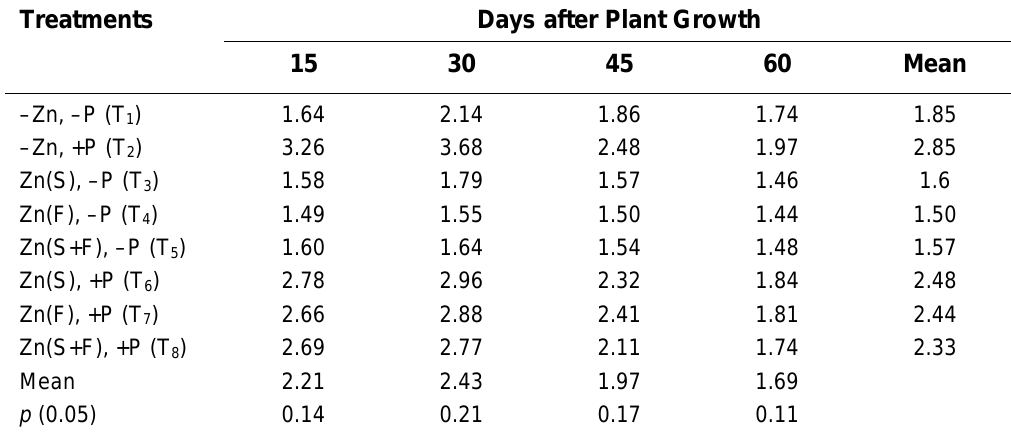
Days after Plant Growth Treatments